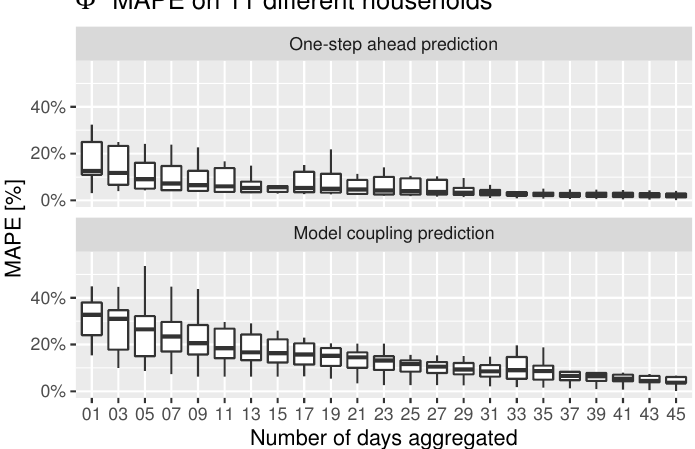
Figure 11. MAPE of the space heating consumption of 11 households, aggregating data to daily